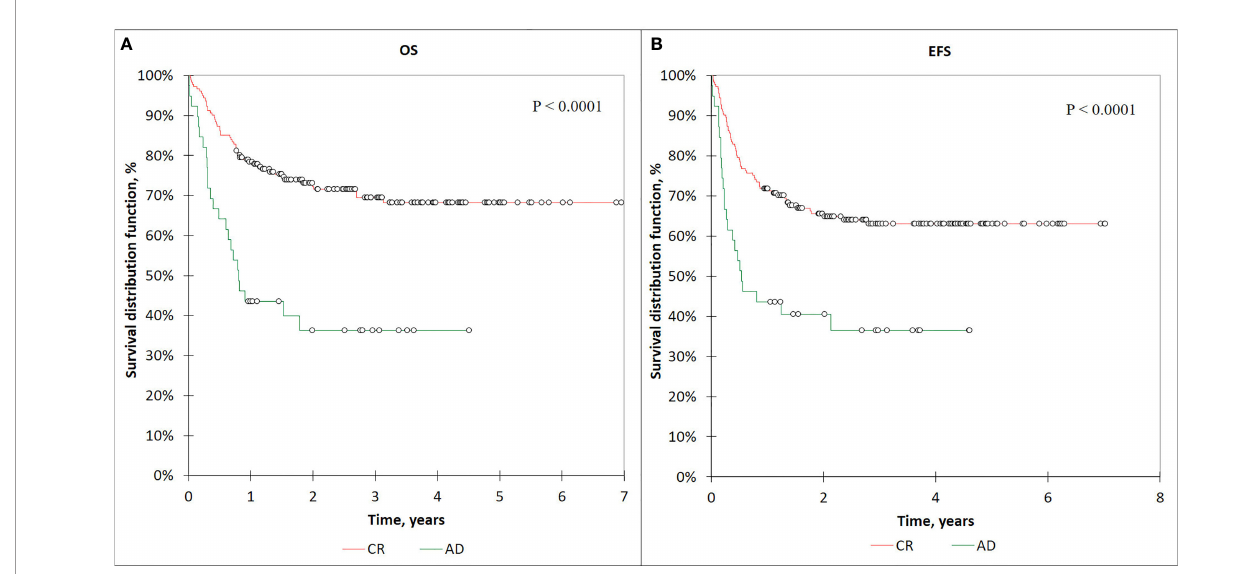
FIGURE 7 | The OS (A) and EFS (B) curves for the CR and AD